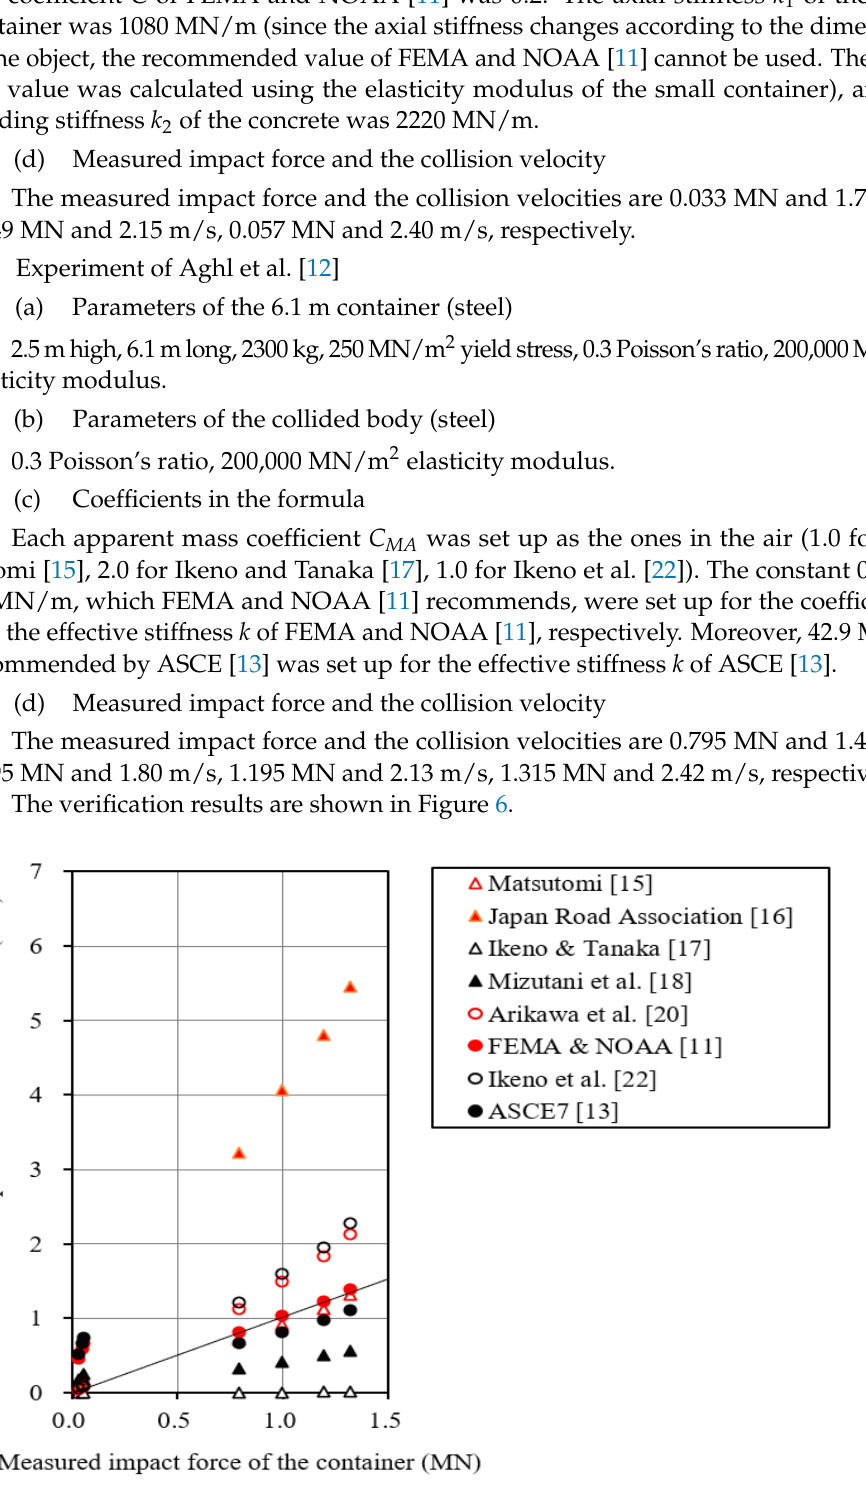
Figure 6. Comparison of impact forces for the containers.